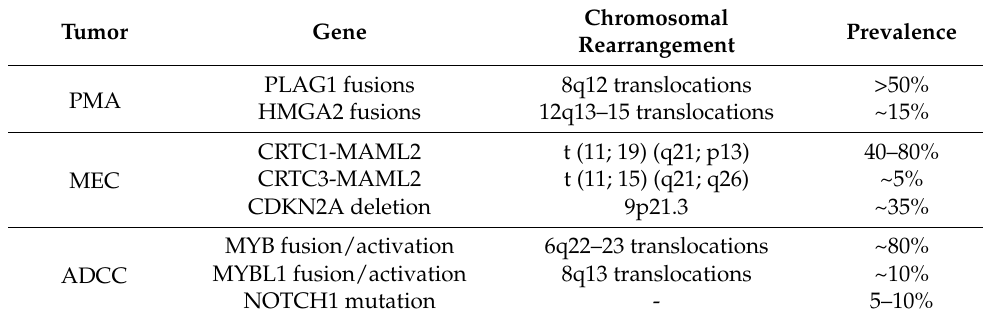
Table 6. Overview of translocation types and prevalence.